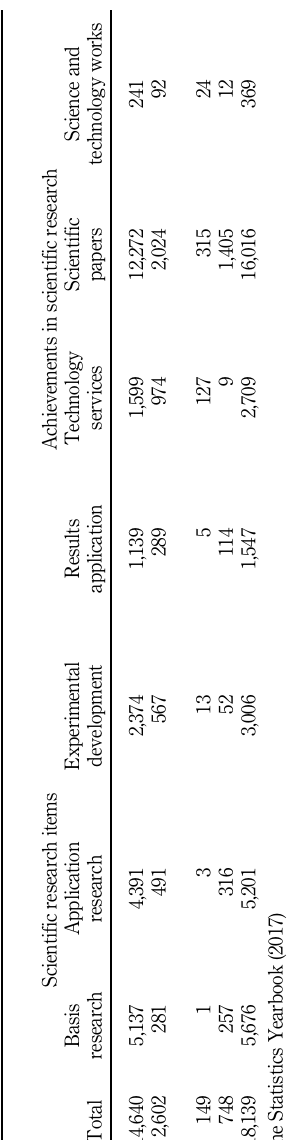
Table 1. China ’ s marine science and technology R&D achievements in